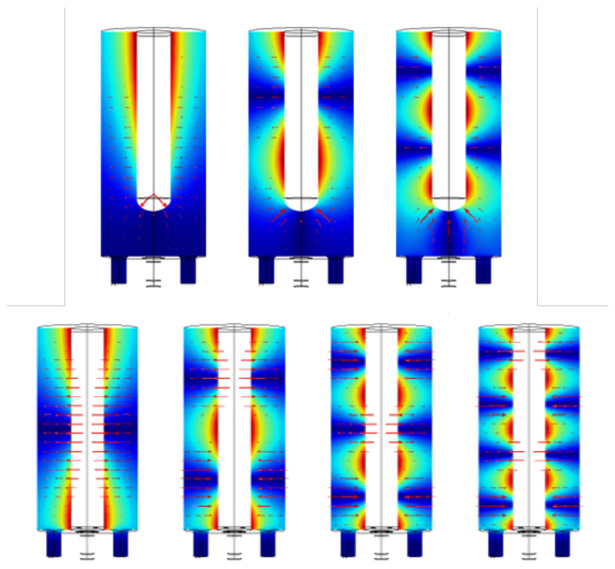
FIG. 2. Field distribution in the QWR (top) and HWR (bottom) in the investigated eigenmodes. The heat map shows the magnetic field and the arrows the electric